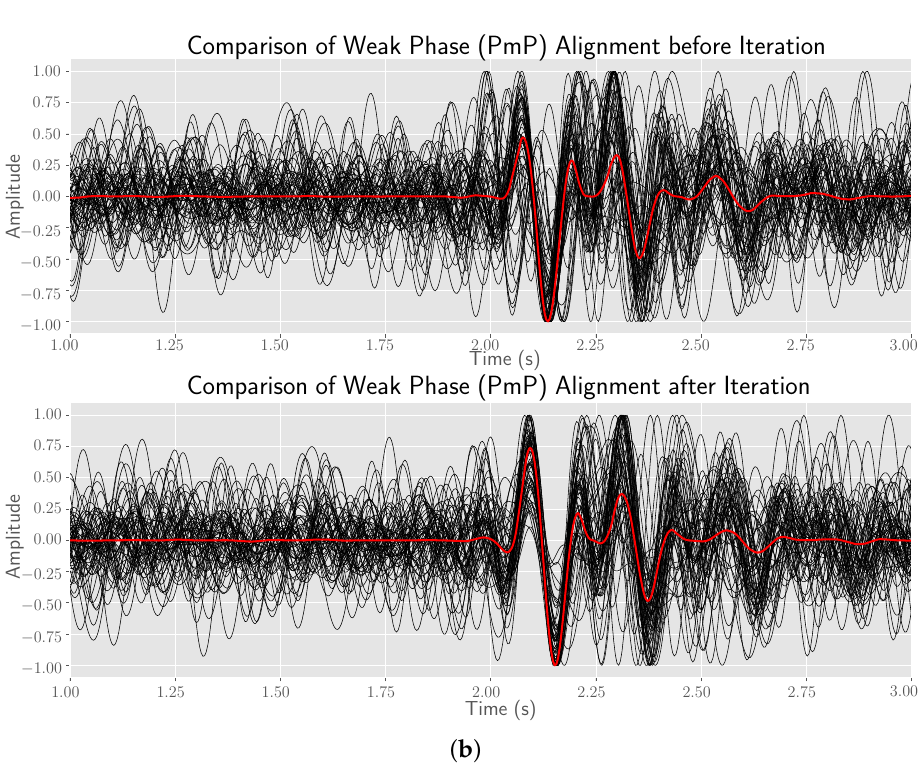
Figure 11. The stacked waveforms of all seismograms within different stages before and after iteration. ( a ) The first stage corresponds to the traces 213 270; ( b ) the second stage corresponds to the traces ∼ 135 196. The black solid line is the segment of each seismogram (the starting point is 2 s before ∼ arrival and the ending point is 3 s after arrival), and the red solid line is the stacked waveform of all